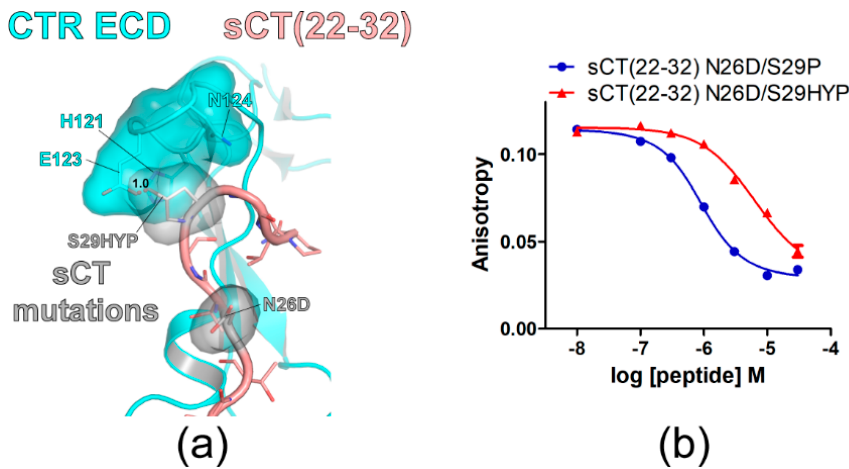
Figure 3. sCT S29 to hydroxyproline mutation markedly decreased sCT(22–32) affinity for CTR ECD. ( a ) The hypothetical structure of CTR ECD (PDB 6PFO, Mol A) with sCT(22–32) N26D/S29HYP mutations. CTR ECD H121, E123, and N124 and sCT N26D and S29HYP mutated residues were shown both with stick and surface representations. The distance between sCT HYP29 and CTR ECD E123 was shown as a dotted red line and was measured as 1.0 Å. ( b ) FP competition peptide binding assay with sCT(22–32) N26D/S29P and N26D/S29HYP mutations. FITC-sCT(22–32) was used as a peptide probe. Representative peptide-binding curves were shown from three independent experiments.